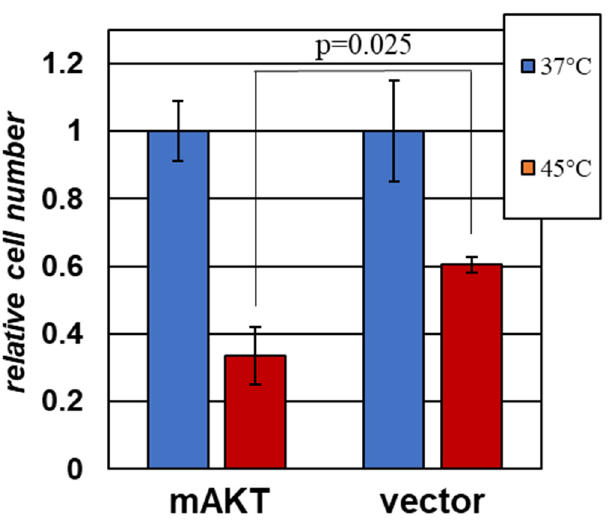
Figure 5. A human melanoma cell line is sensitized to hyperthermia upon expression of hyperac- tive AKT. A375 melanoma cells harboring either mAKT or the corresponding empty vector were treated for 60 min at the indicated temperatures. The remaining cells were scored after 24 h of recovery under normal growth conditions. The data from triplicate experiments for each cell line are shown normalized to the average values in the respective control (37 °C) populations.